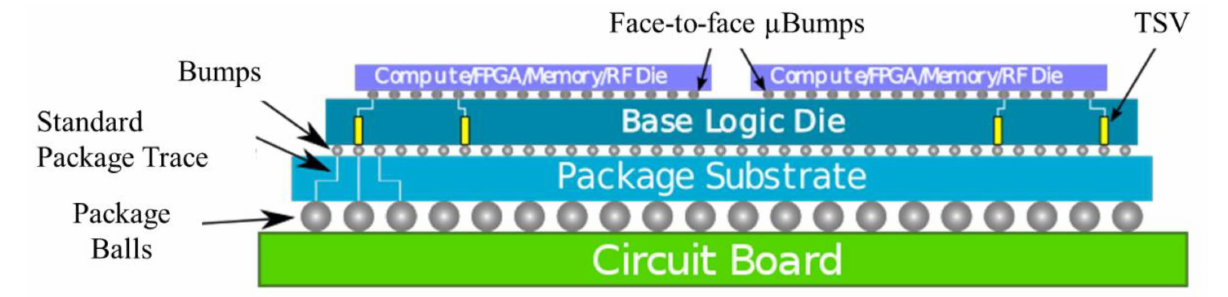
Figure 7. Foveros architecture (reprinted from Ref. [47], Copyright 2020, with permission from